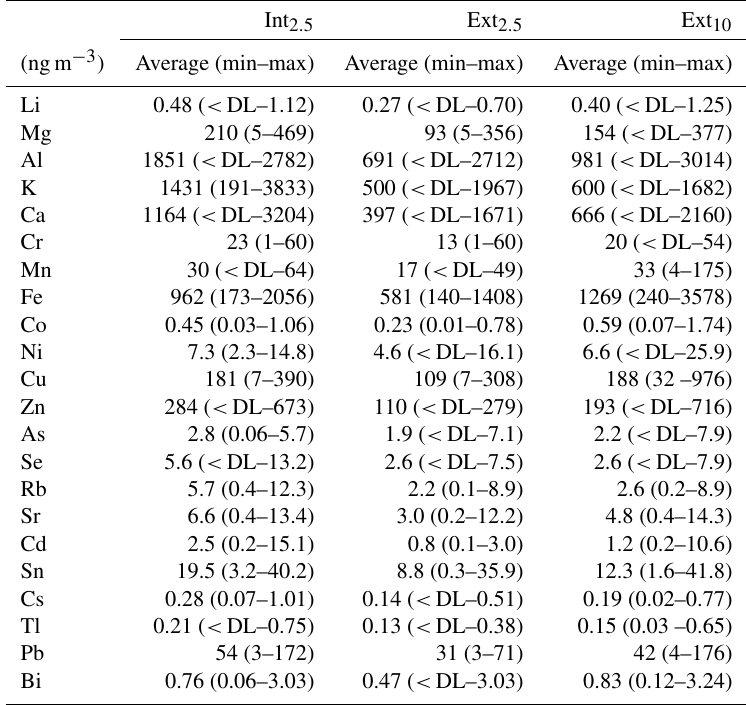
Table 4. Average, minimum and maximum concentrations of tracer elements for all